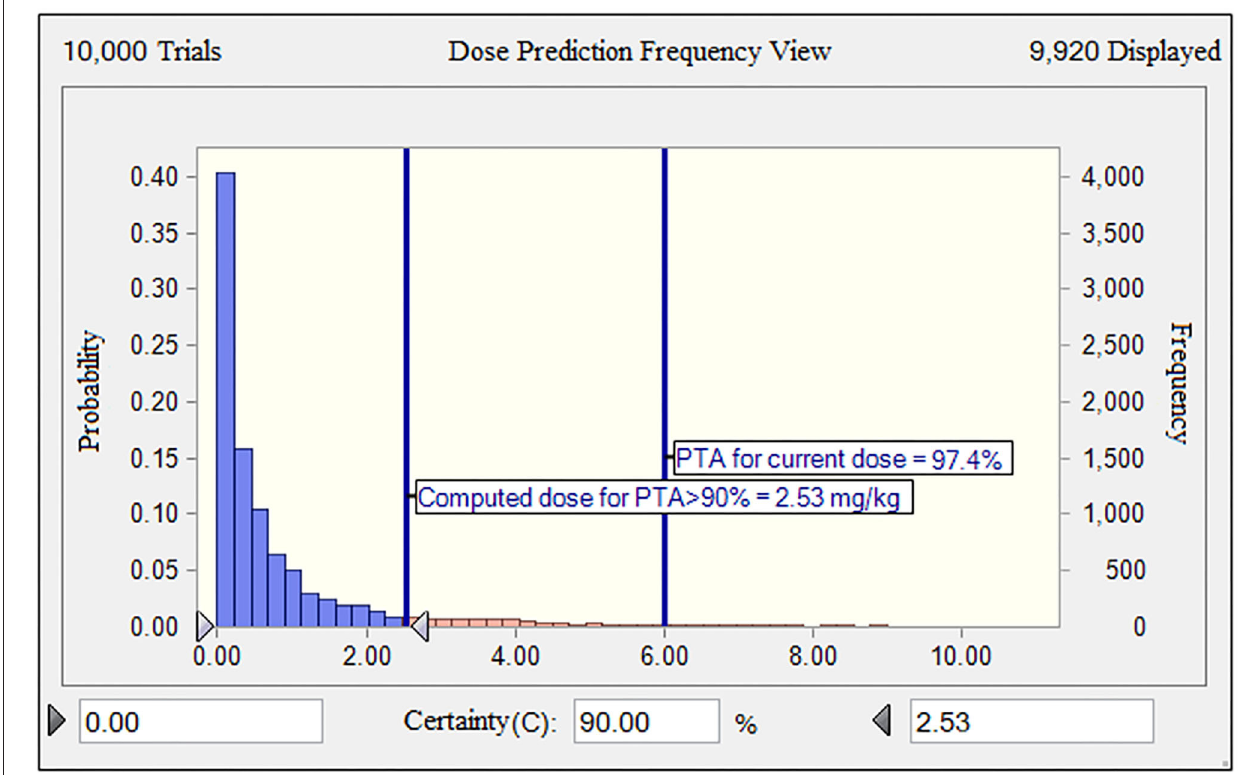
FIGURE 6 | The population distributions of gamithromycin doses, as predicted by a PK/PD model against S. suis for a duration of action of 3 days in terms of probability of target attainment (PTA; y -axis). The vertical bars indicate the PTA (97.4%) for the current nominal dose of 6.0 mg/kg and the calculated target dose (2.53 mg/kg) for a PTA of > 90% to cover the observed wild-type MIC distribution of S. suis obtained in this study. The dose range of 0–10 mg/kg was indicated on the